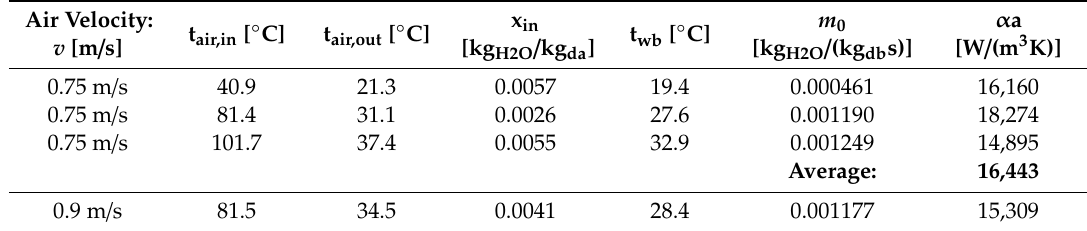
Table 3. The calculated values for the term α a for the bed height of 200 mm. Bulk density of mixture 116 kg db / m 3 in all cases.